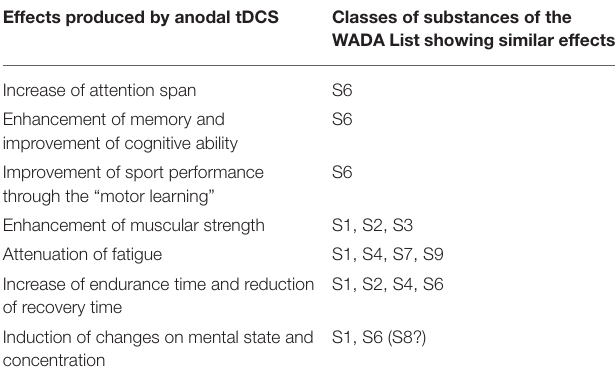
TABLE 1 | Summary of the reported effects of anodal tDCS and their similarities with those of the classes of prohibited substances presently included in the “Prohibited List” of the World Anti-Doping